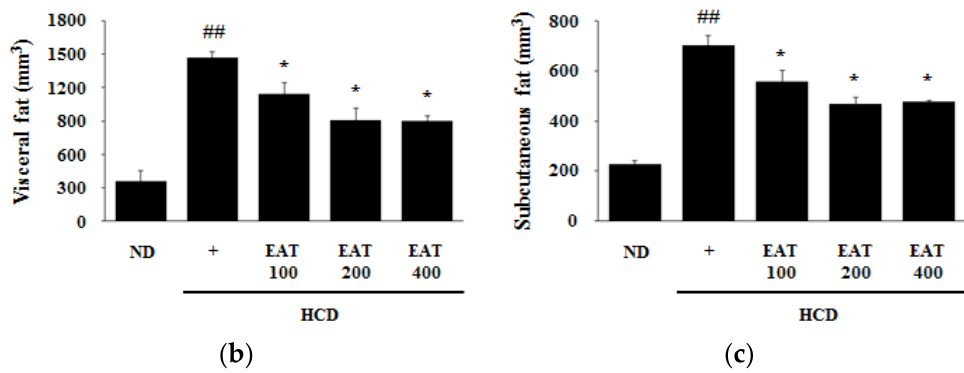
Figure 1. Effect of EAT on the change of body fat profile in an HCD-induced C57BL/6 mouse model. ( a – c ) To assess the change of fat accumulation induced by HCD, mice were anesthetized and ( a ) body fat accumulation, including ( b ) visceral and ( c ) subcutaneous fat, was measured by microcomputed tomography (micro-CT) at the end of experiment. Values are expressed as mean ± SD; ## p < 0.01 compared with the ND group; * p < 0.05 compared with the HCD group.